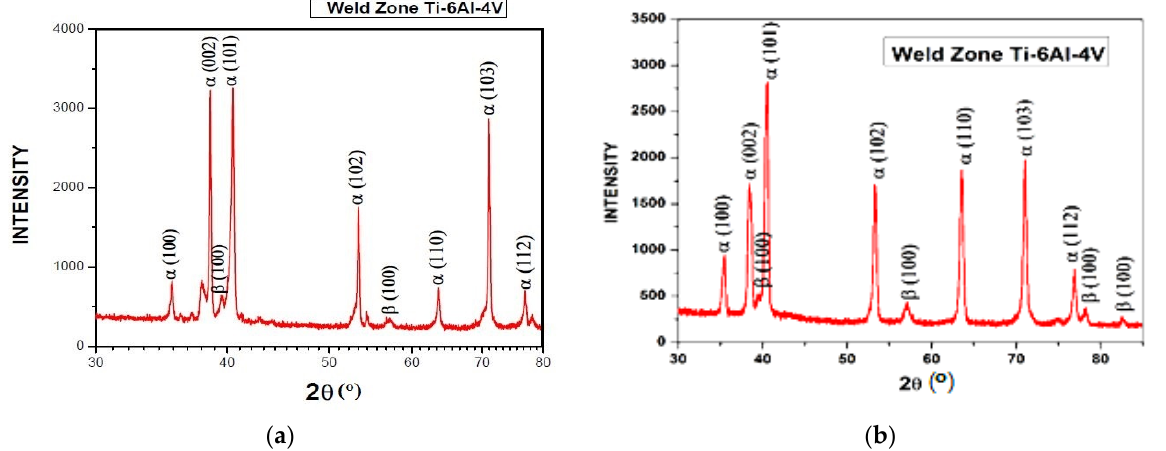
Figure 14. ( a ) XRD pa tt ern for an annealed sample at 980 °C [18]. ( b ) XRD pa tt ern for overlapped sample (A-2). sample